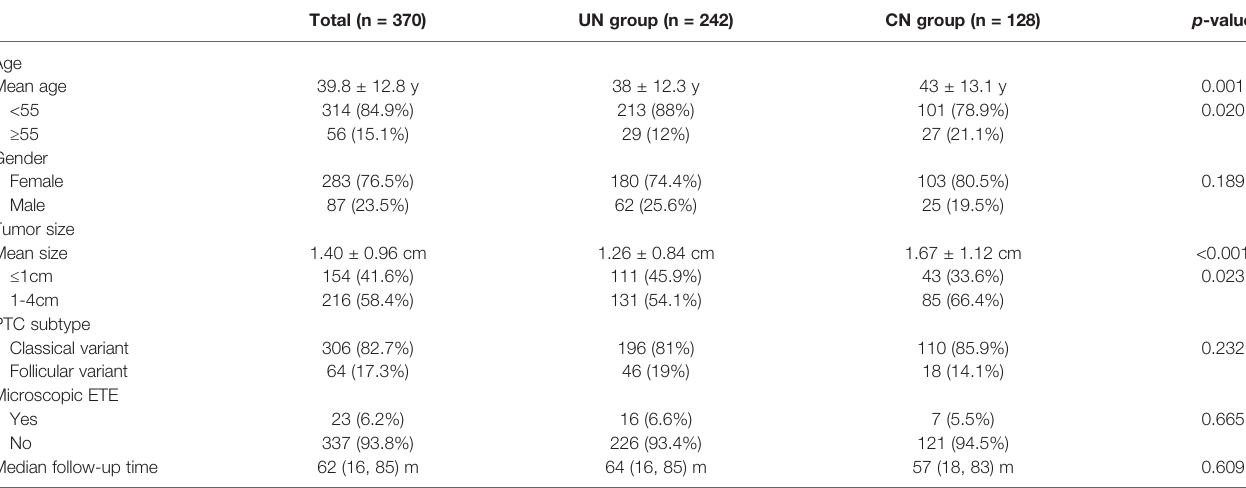
TABLE 1 | Comparison of patient and tumor characteristics between the UN and CN nodule